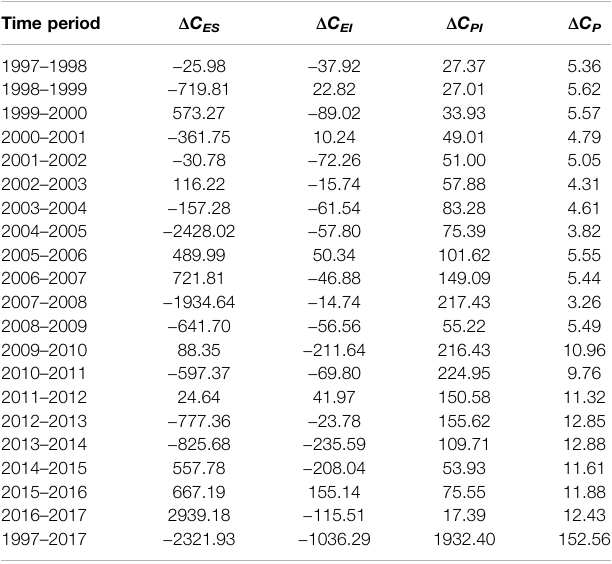
TABLE 4 | Decomposition of energy-related carbon emissions changes (ten thousand